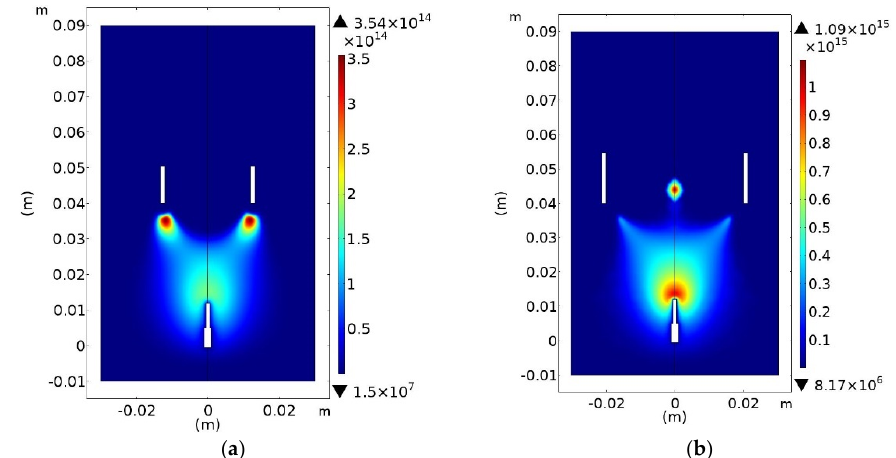
Figure 9. Spatial distributions of electron density (m − 3 ) for the optimal thruster output: ( a ) thruster with argon as propellant gas; ( b ) thruster with xenon as propellant gas.